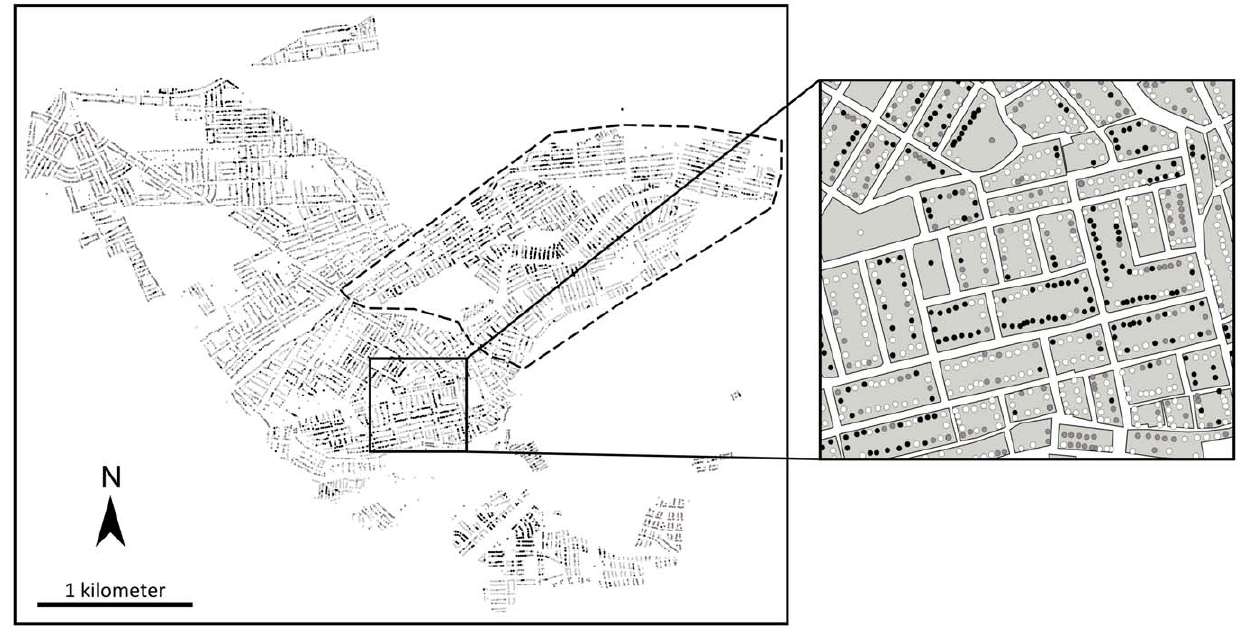
Figure 2. Spatial distribution of Triatomainfestans presence in households of Paucarpata, Arequipa, Peru. Map of the study area. Black indicates infested households, white non-infested households, and grey non-inspected households. The area encircled by dashes was used to fit the Gaussian Field Latent Class model; the remaining area was used as a validation dataset. The close-up shows the urban grid underneath and the aggregation of vectors within city